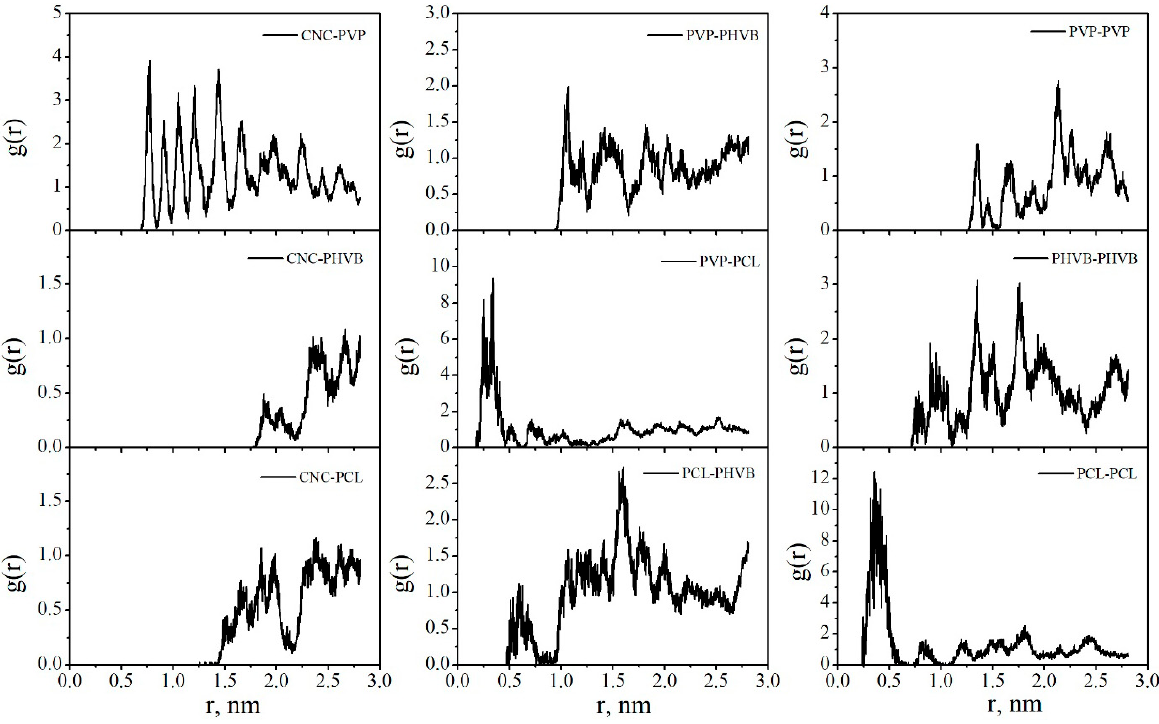
Figure 28. The radial distribution functions between the centers of mass of the composite components in vacuum.